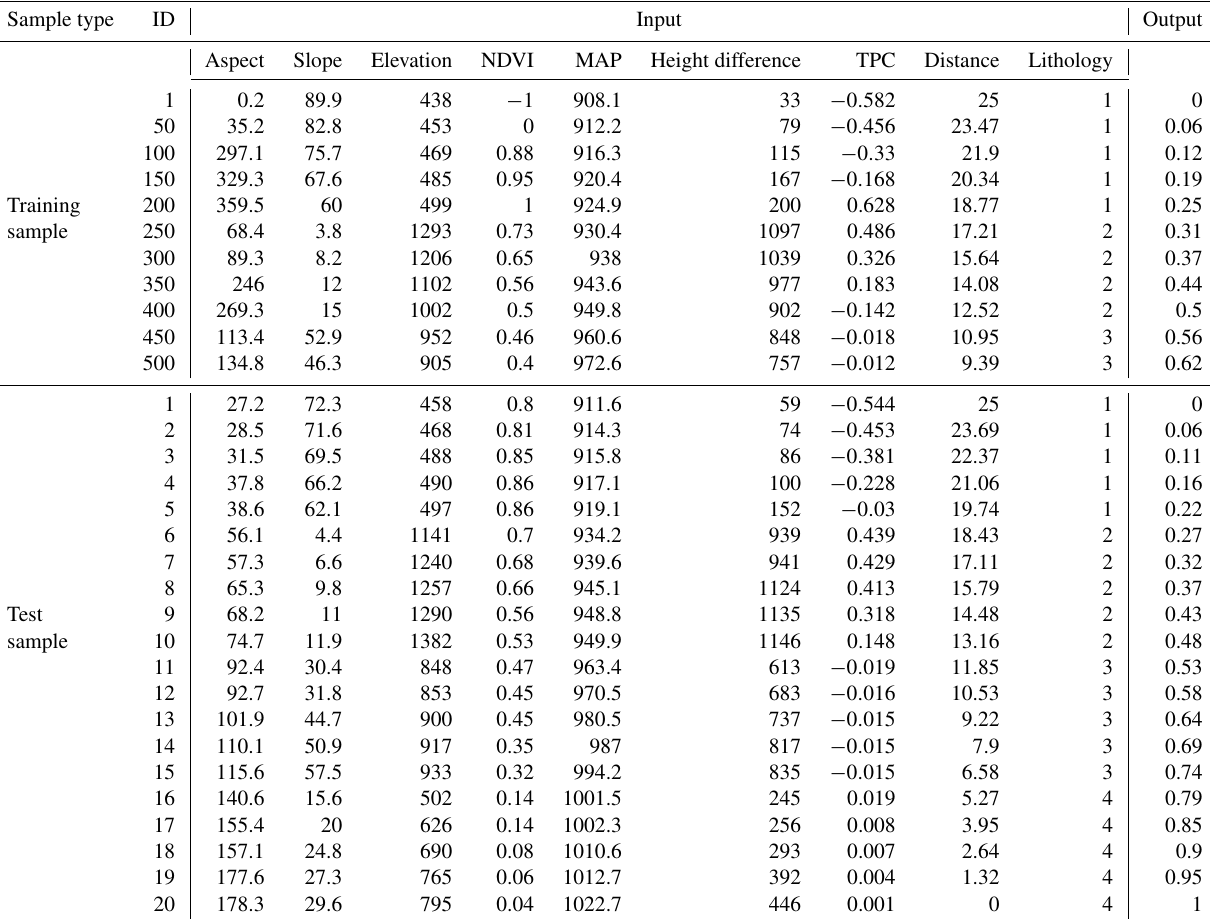
Table B1. Standard training sample matrix and standard test sample